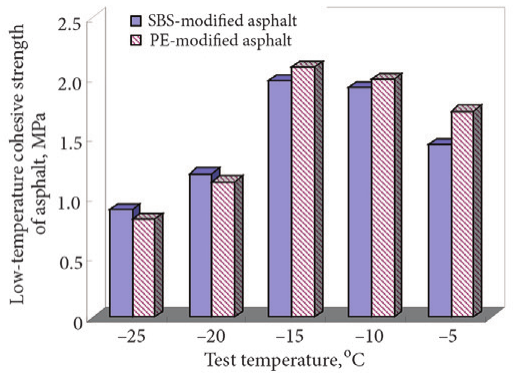
Figure 6. Change law of the two types of bitumen low-temperature cohesive strength after ageing for 18 h